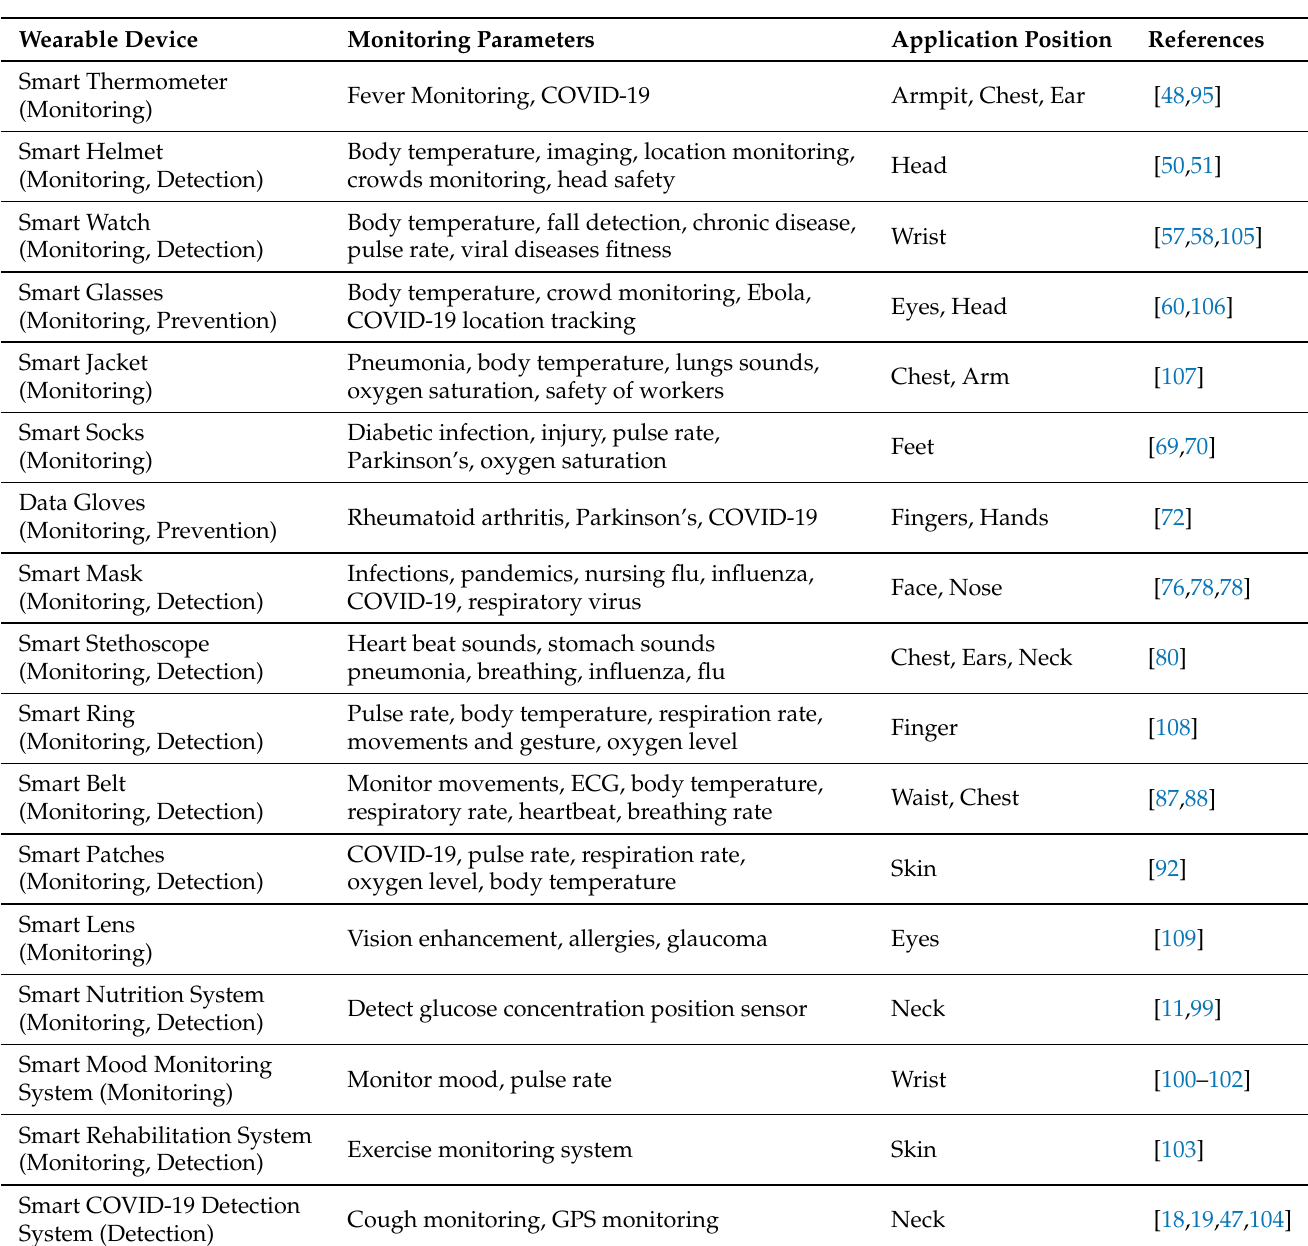
Table 2. Comparison of wearable